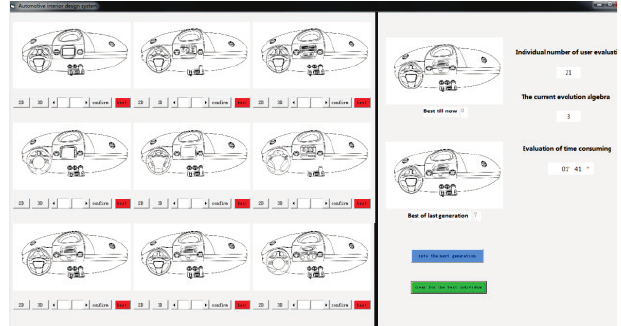
Fig.6. The interactive interface for customization design system of console